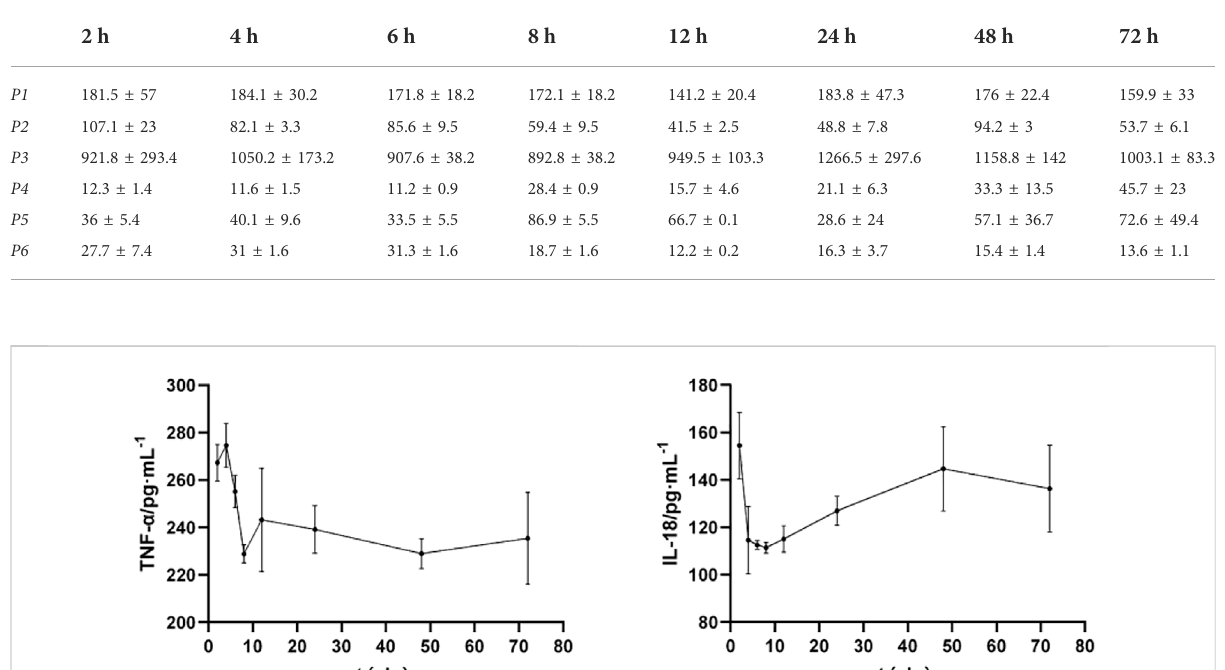
TABLE 1 The peak areas in the rat plasma at different time points ( (cid:1) x ±s, n = 6).